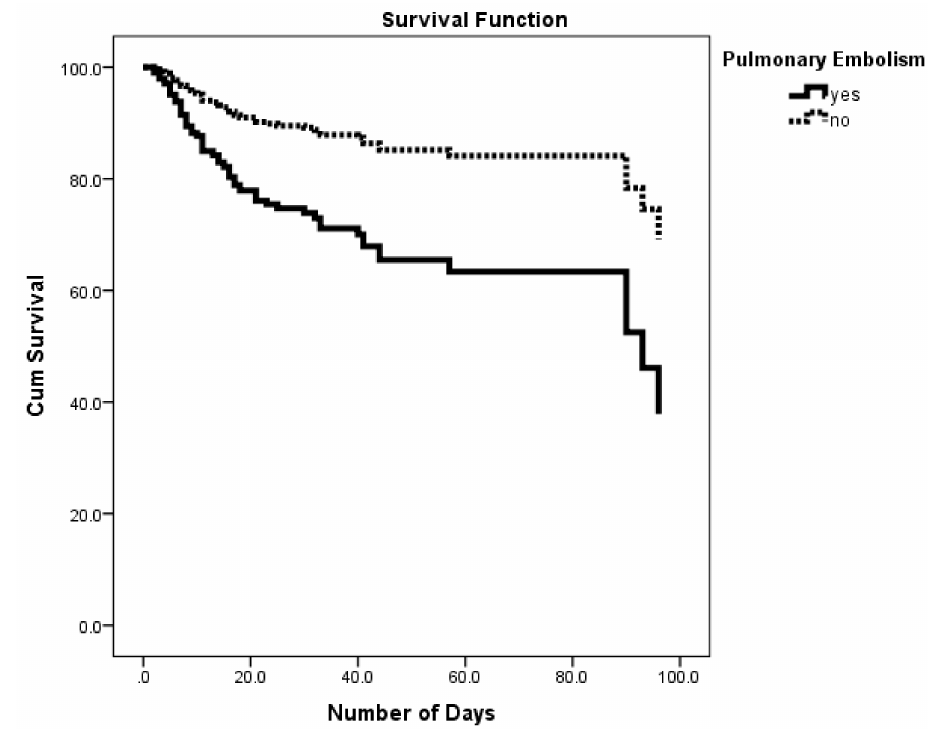
Figure 4. Survival rates for in-hospital stroke patients by pulmonary